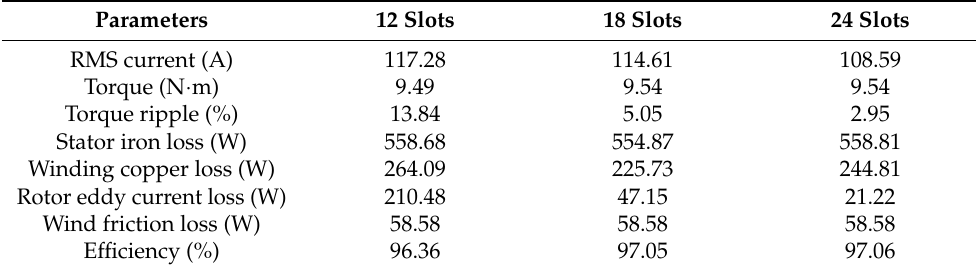
Table 4. Performances of 12 slots, 18 slots and 24 slots HSPMMs under full − load condition.